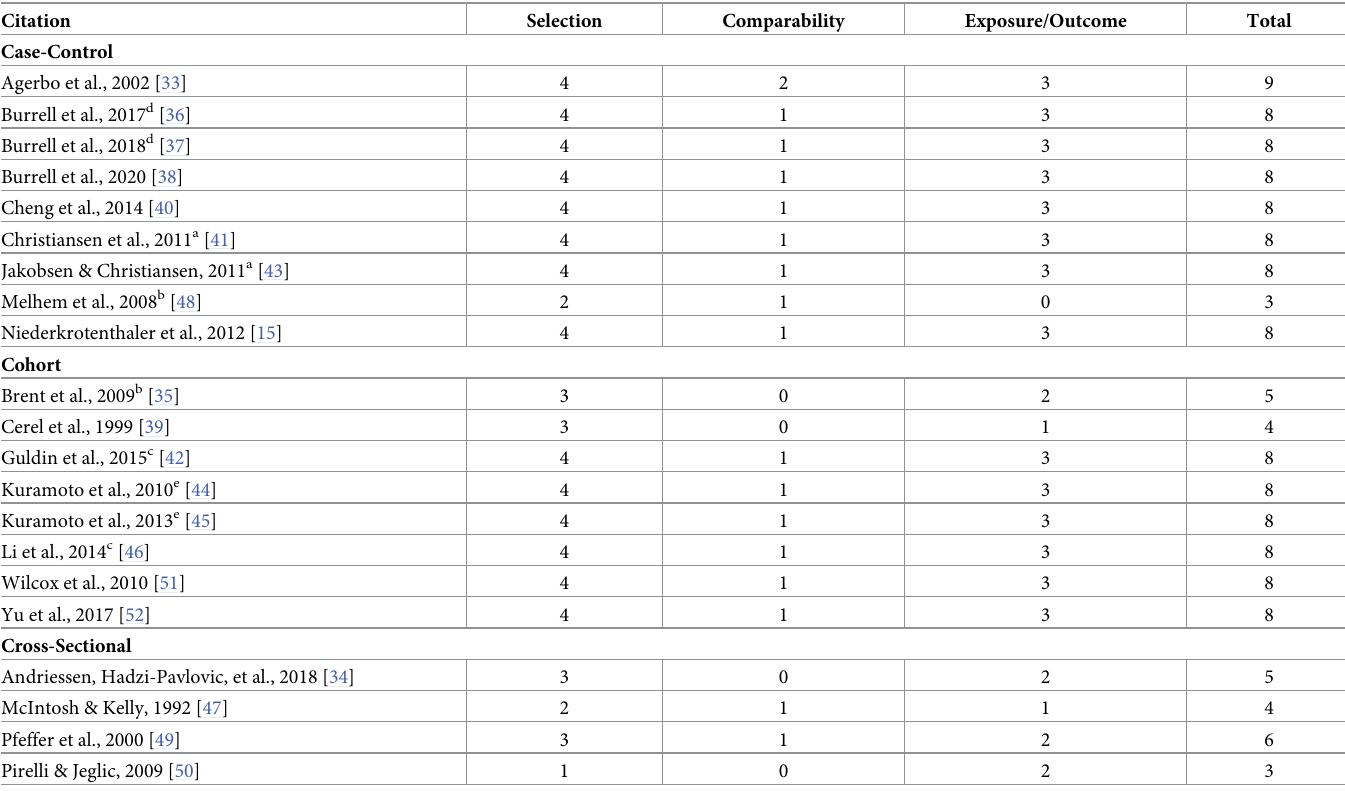
Table 2. Risk of bias assessments of included studies according to study design.